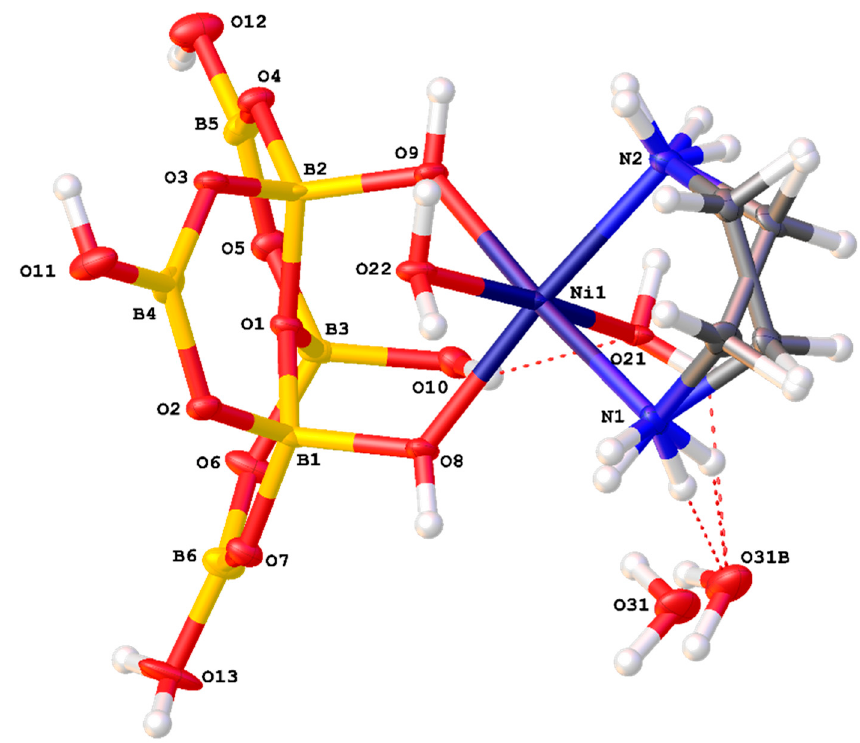
Figure 3. Drawing of structure trans -[Ni(en)(H 2 O) 2 {B 6 O 7 (OH) 6 }] . H 2 O ( 7 ), showing selected crystal- lographic numbering.